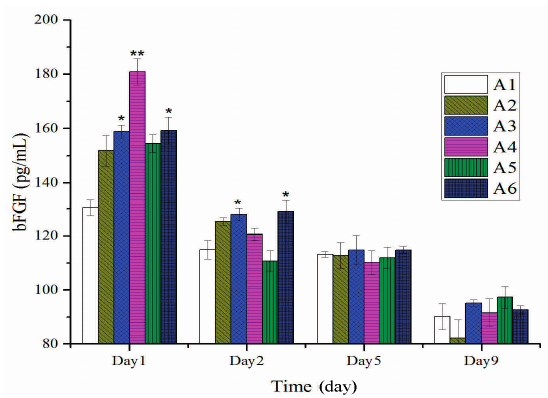
Figure 6. Expressions of bFGF in tissues after treatment with BBO in rats. Values are expressed as mean ± S.D. ( n = 4 animals). * : p < 0.05 vs. control; ** : p < 0.01 vs. control.